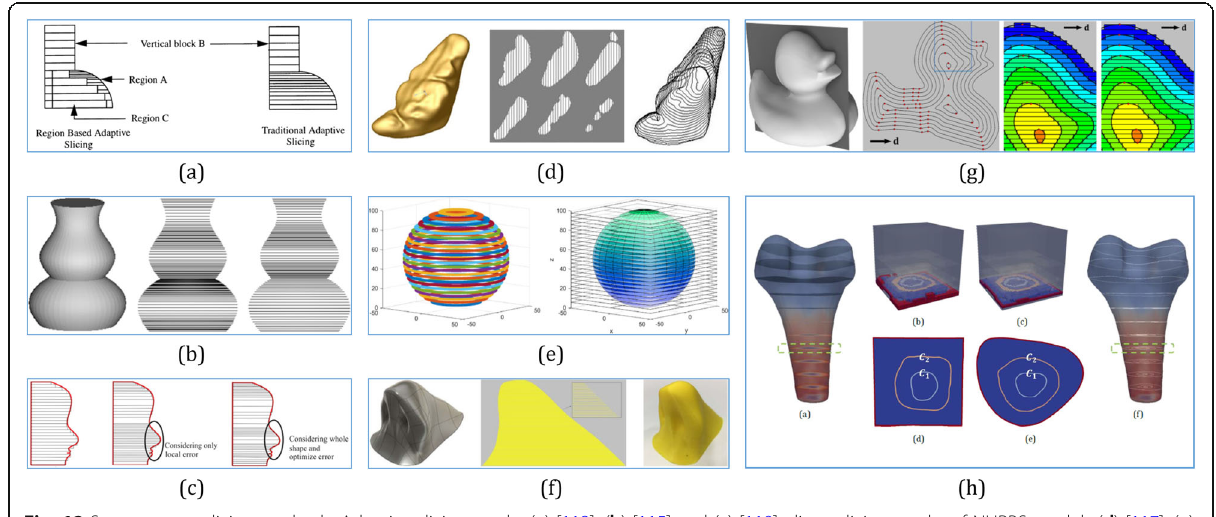
Fig. 12 Some current slicing methods: Adaptive slicing results ( a ) [113], ( b ) [115] and ( c ) [118]; direct slicing results of NURBS models ( d ) [117], ( e ) [120], and T-spline models ( f ) [120]; direct slicing results of trivariate NURBS models ( g ) [64], and trivariate T-splines ( h )